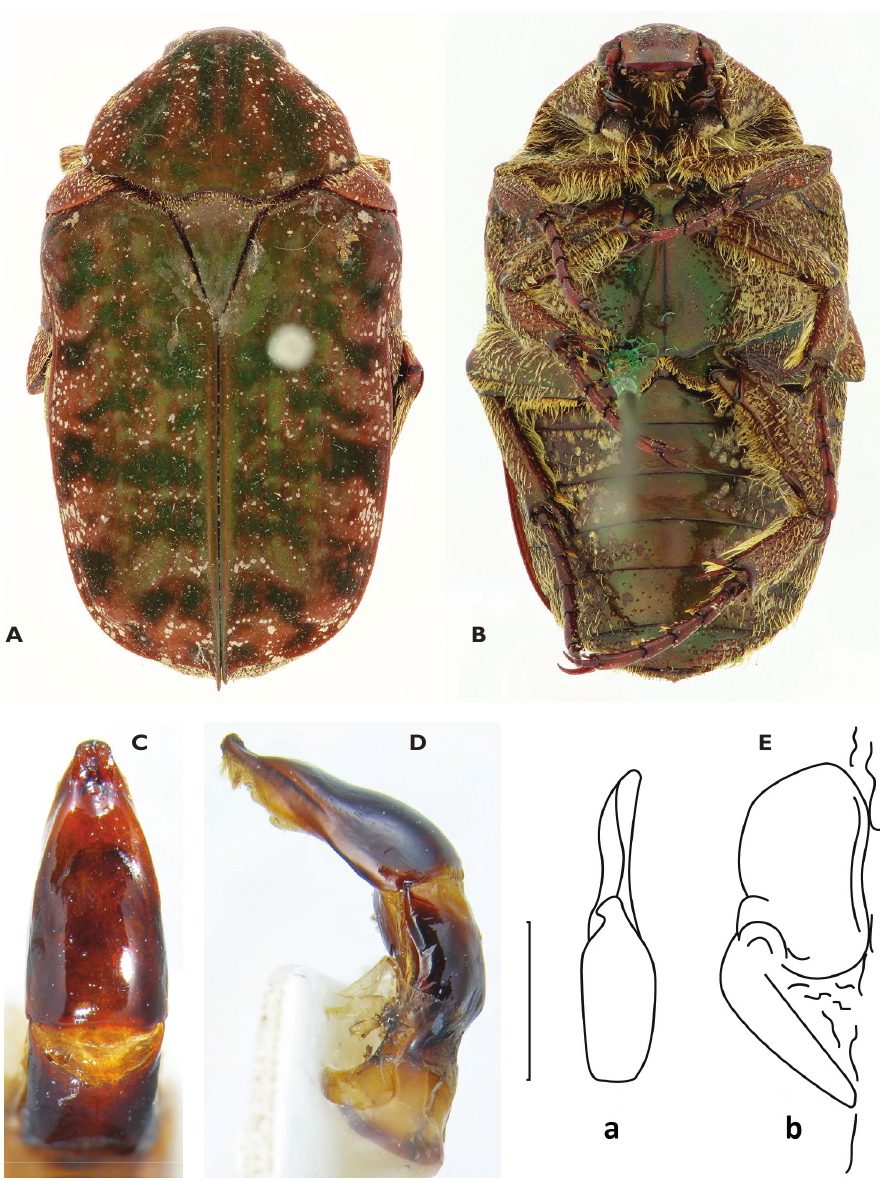
Figure 1. Anelaphinis dominula (Harold, 1879), Holotype (MNHU). A Dorsal view B ventral view C parameres in dorsal view D parameres in lateral view E sclerite of internal sac ( a dorsal view; b lateral view) (Scale bar = 1